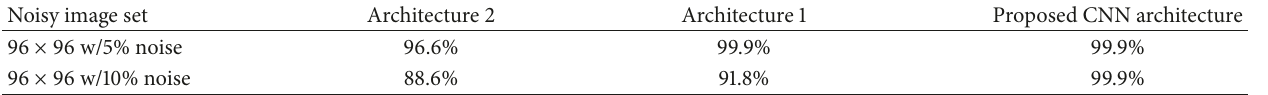
Table 27: Prediction accuracies for MFPT scalograms with injected noise.